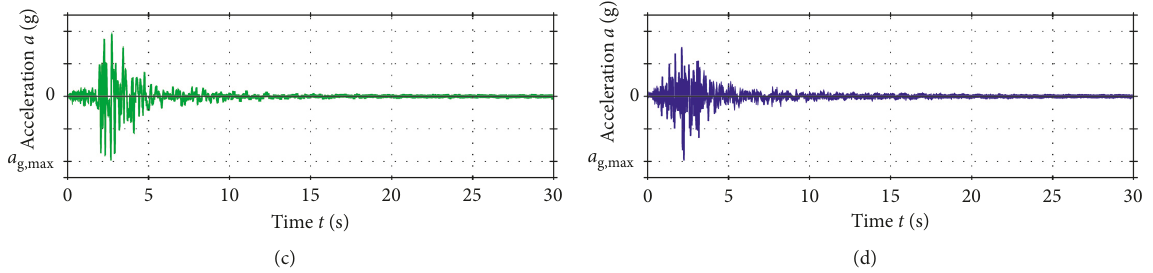
Figure 6: Applied horizontal base accelerations ( a g,max scaled to 0.2g for MSSB and 0.3g for MSB). (a) Artificial accelerogram (AA). (b) N-S accelerogram of Petrovac earthquake (AP). (c) N-S accelerogram of Ston earthquake (AS). (d) N-S accelerogram of B. Luka earthquake (ABL).